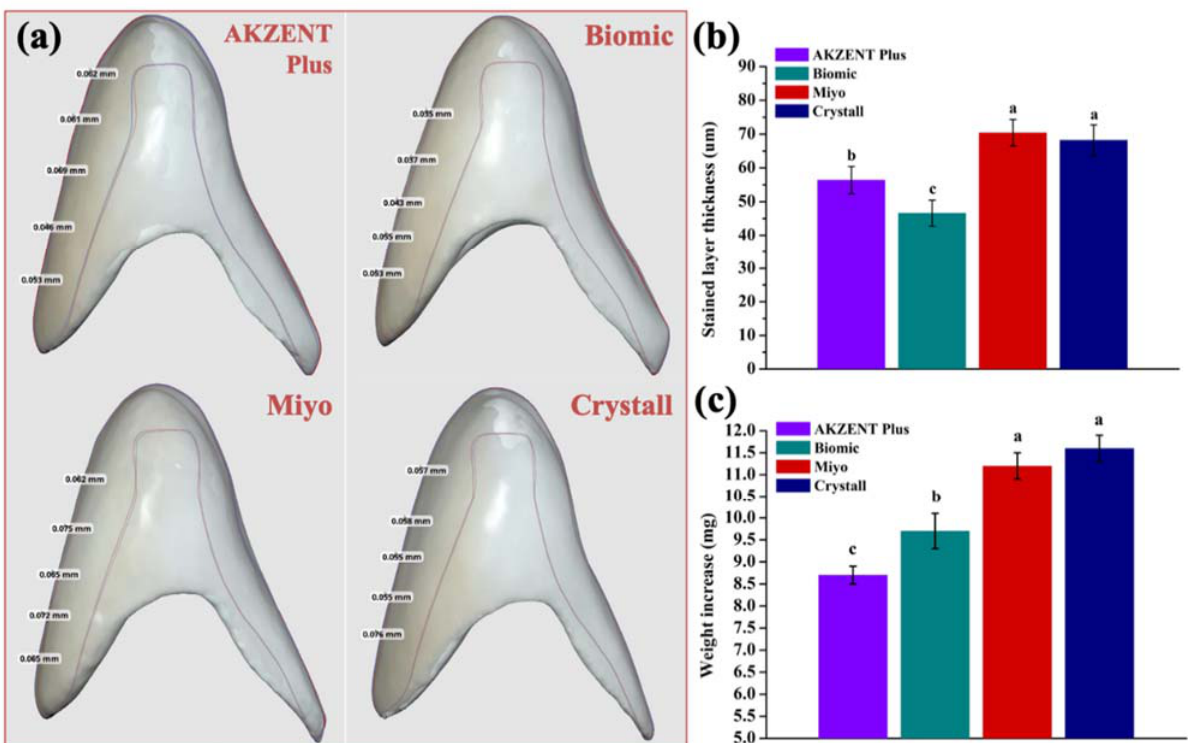
Figure 11. Thickness and weight of stained layers after the staining of zirconia crowns. ( a ) Digital comparison, ( b ) thickness of stained layers, and ( c ) weight of stained layers. Means with different letters were significantly different ( p < 0.05, mean ± SD, n = 5).